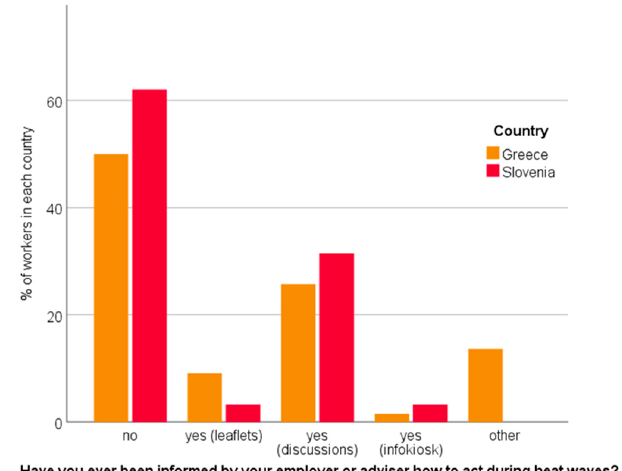
Figure 6. Workers’ reports on how they were (or were not) informed about heat